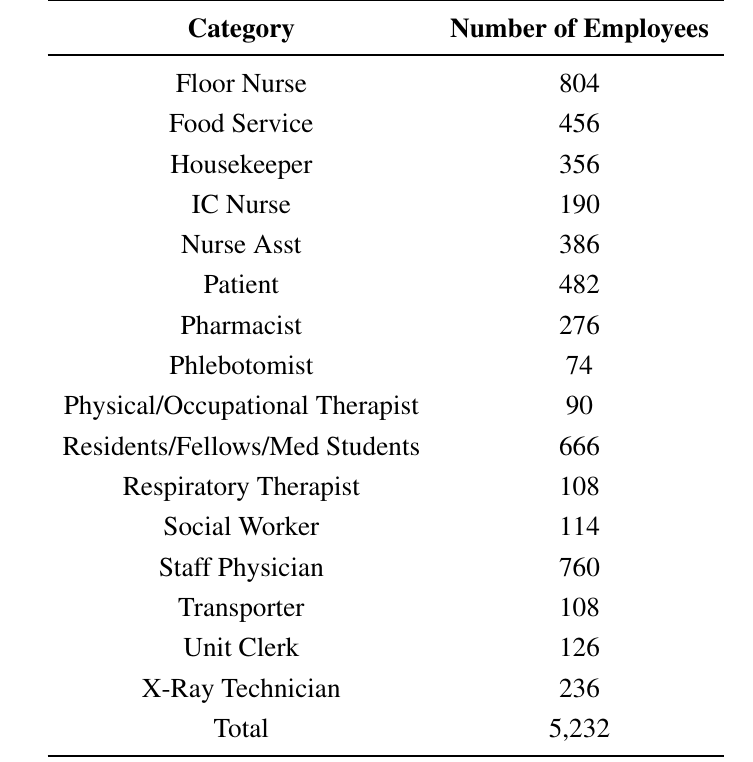
Table 1. The number of employees at the